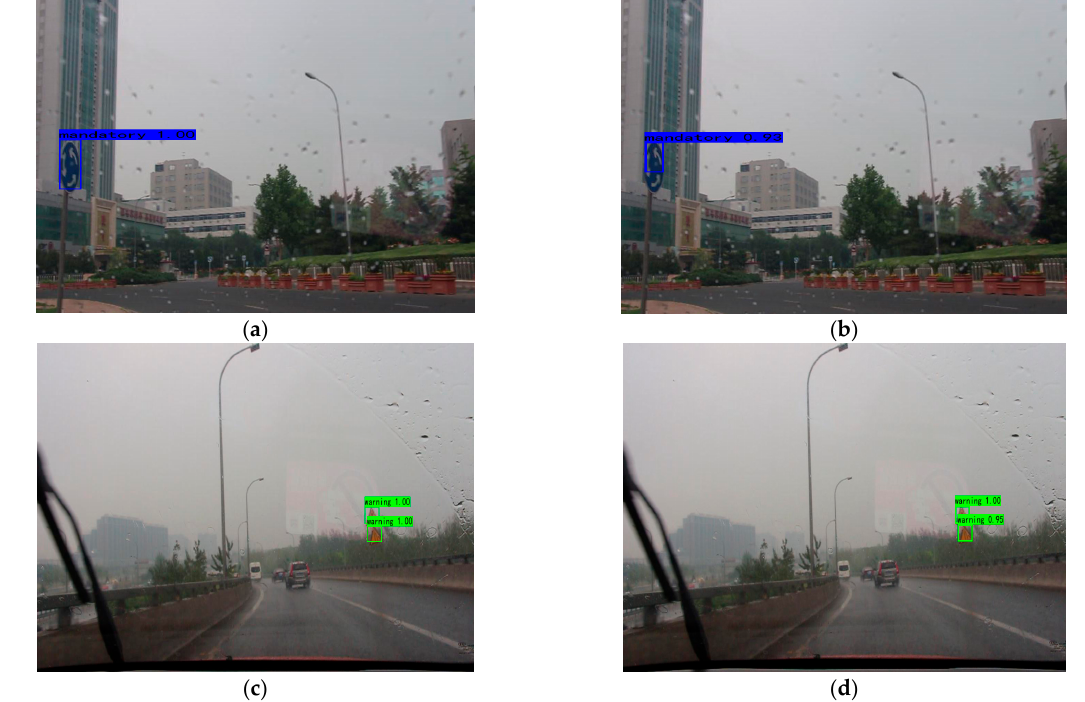
Figure 16. Comparison results of different algorithms in rainy weather, where ( a , c ) are the results of TSR-YOLO, ( b , d ) are the results of YOLOv4-tiny.